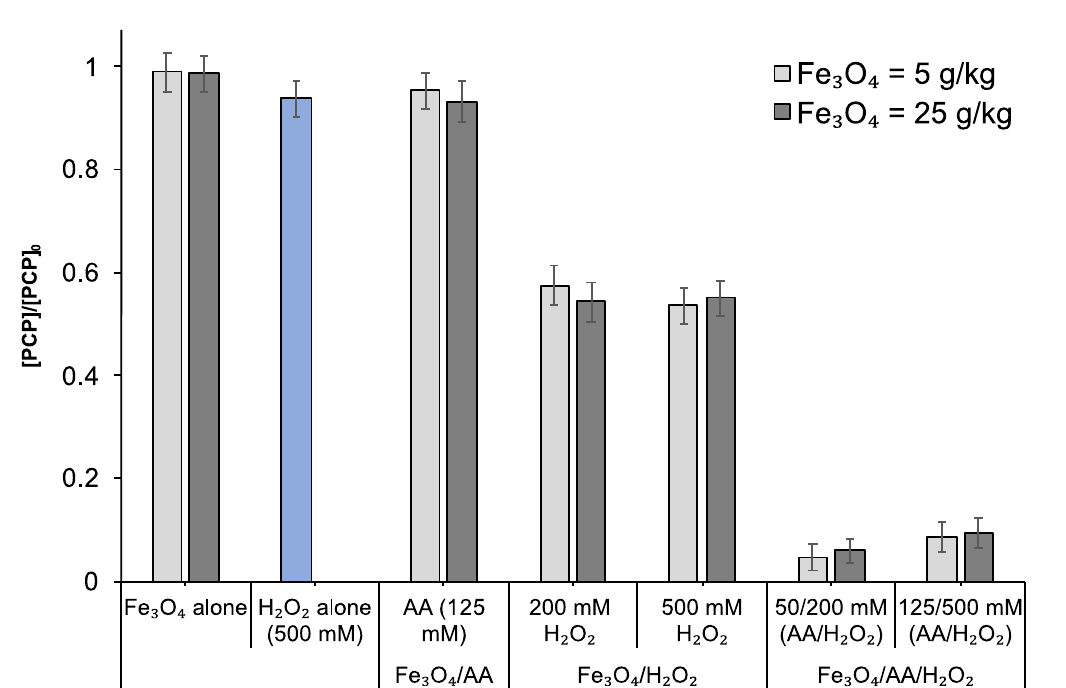
Figure 1. Degradation of PCP in contaminated soil (PCP = 6 mg Kg − 1 ) evaluated in the presence of two different amounts of magnetite- Fe 3 O 4 (5 or 25 g kg − 1 soil w/w) by using single (Fe 3 O 4 alone, H 2 O 2 alone), binary (Fe 3 O 4 /AA and Fe 3 O 4 / H 2 O 2 ), and ternary treatments (Fe 3 O 4 /AA/H 2 O 2 ). Experiments were performed in batch conditions at a liquid-to-solid ratio (L/S) of 1 (total solution volume = 2 mL) without pH adjustment (initial pH = 7.2) for 24 h. [PCP] represents the PCP concentration after oxidation (t = 24 h) and [PCP] 0 is its concentration at t = 0 (before treatment) determined by HPLC.